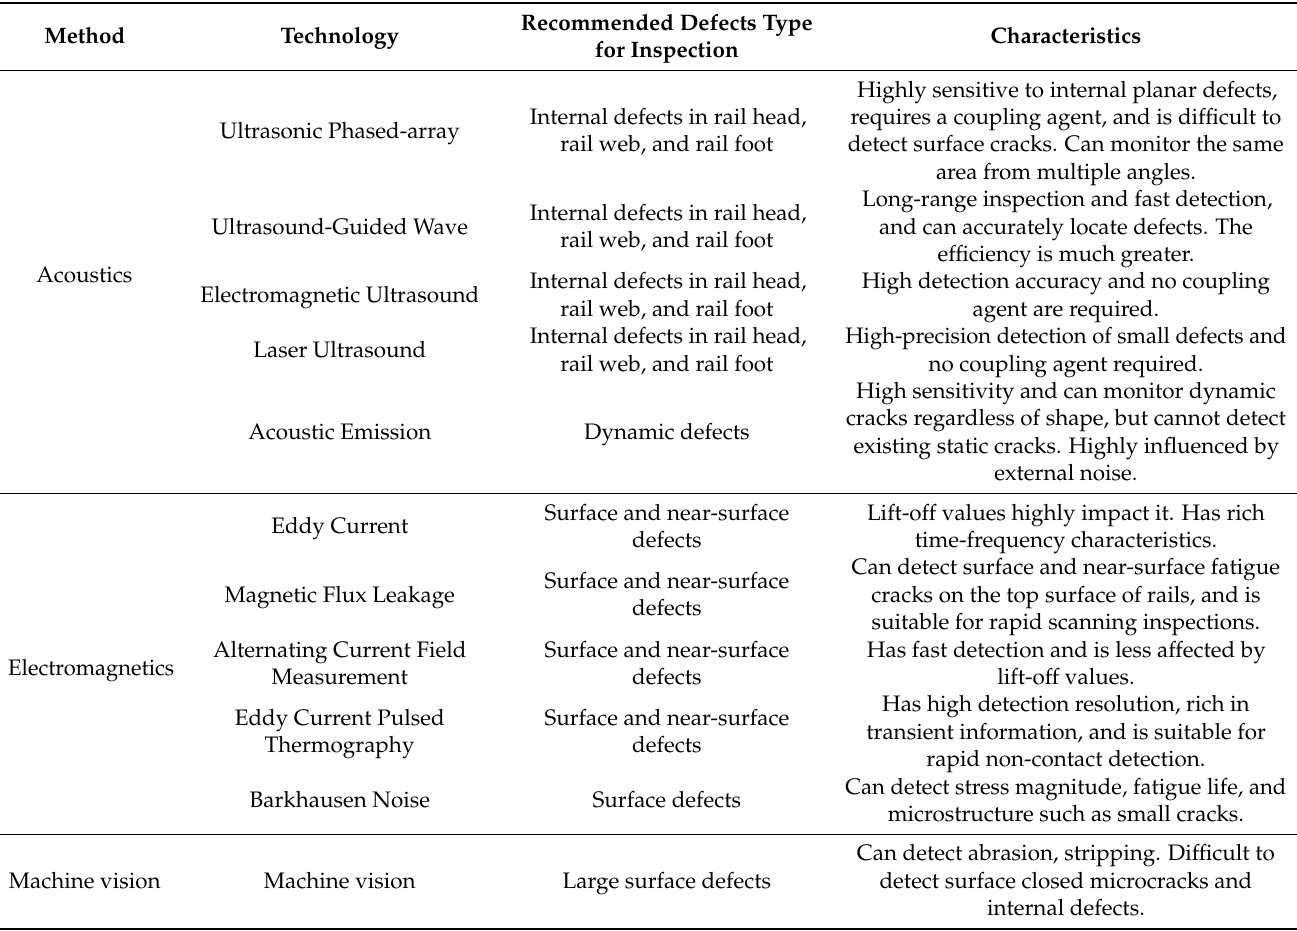
Table 1. Characteristics of different NDT